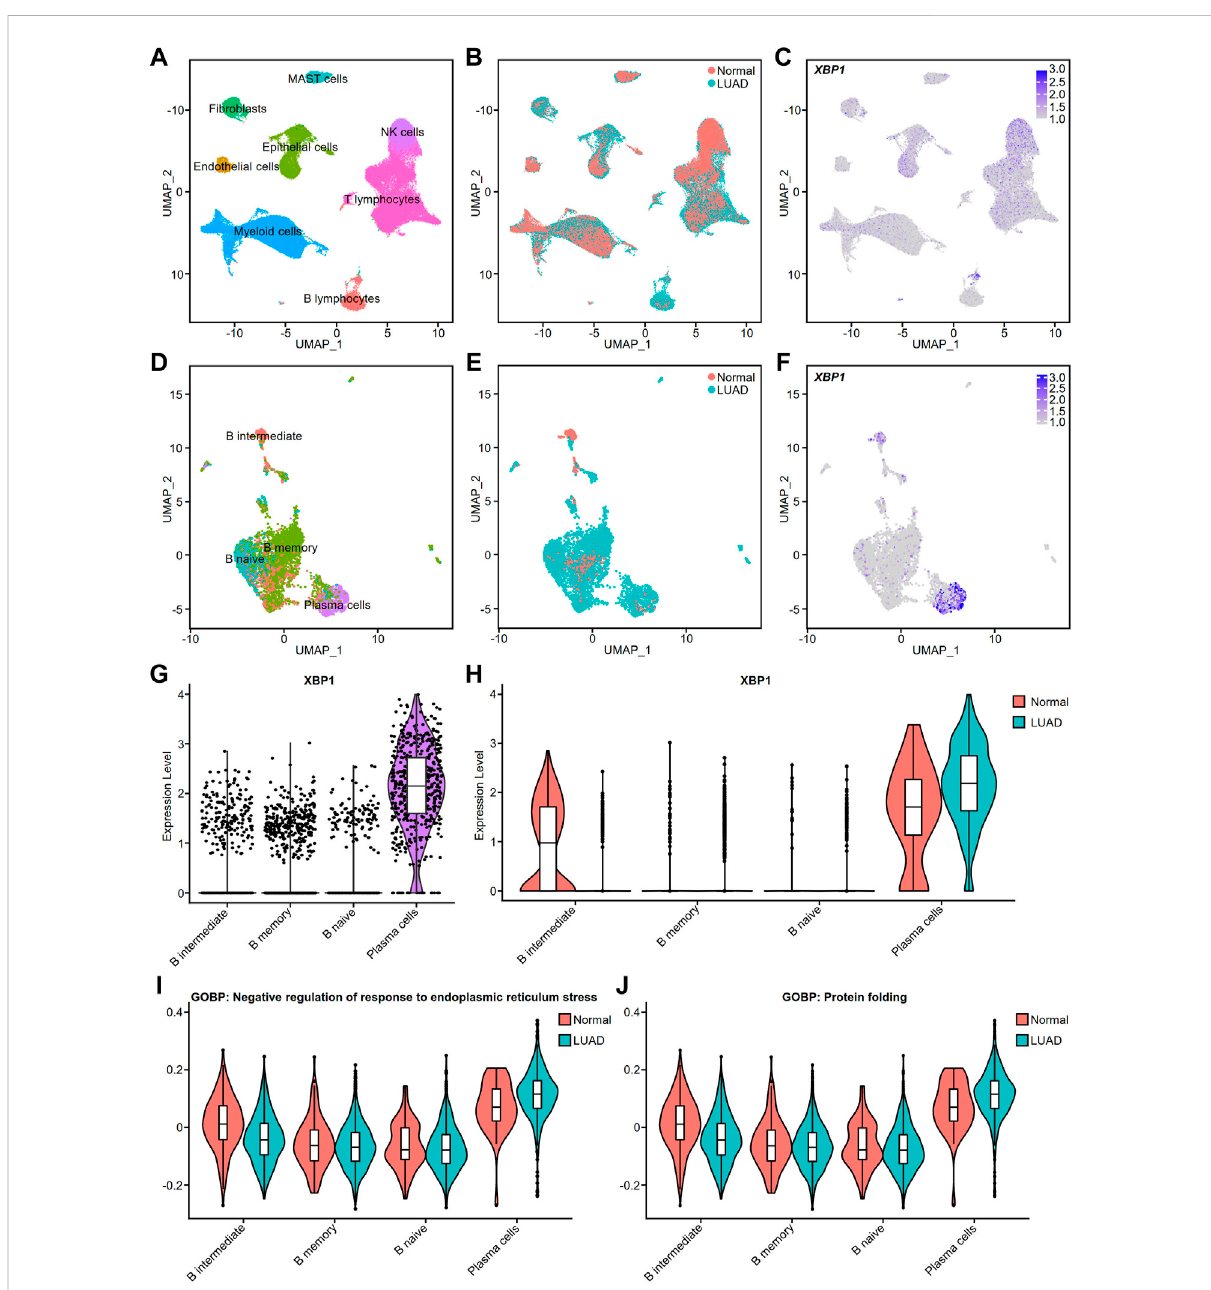
FIGURE 5 Cell type validation and XBP1 expression in LUAD. (A) Single-cell analysis of cell clusters from tumor tissue and distant normal tissue in 11 patients with LUAD. The human lung cell clusters were visualized by UMAP in different colors. (B) UMAP plot of lung cells with LUAD and Normal. (C) XBP1 expression on the UMAP plot of lung tissue. (D) Further single-cell analysis of detailed cell clusters from the B lymphocyte subset (E) LUAD andNormalBlymphocytesUMAPplot. (F) XBP1expressionontheUMAPplotofBlymphocytes. (G,H) ViolinplotofXBP1expressioninvariousB lymphocyte subpopulations. (I) Violin plot of the gene sets involved in the negative regulation of endoplasmic reticulum stress expressed in various cellclustersofBlymphocytes. (J) Violinplotofthegenesetsinvolvedintheproteinfolding expressedinvariouscellclustersofBlymphocytes.Split- violin plots showing the expression of XBP1 in LUAD and Normal. A box plot is embedded in each violin